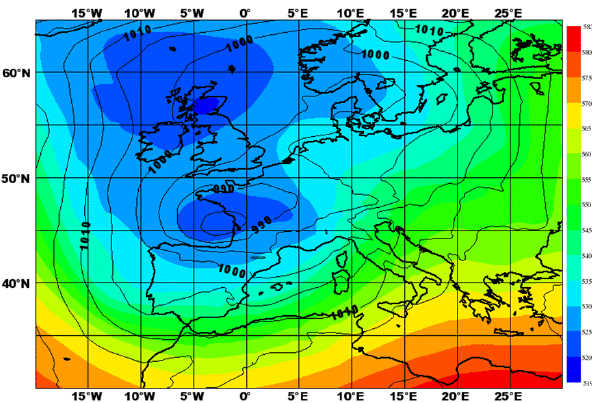
Fig. 2. ECMWF analysis at 00:00UTC, 30 November 2008. Geopo- tential height at 500hPa (gpm, colour shading) and mean sea level pressure (hPa,